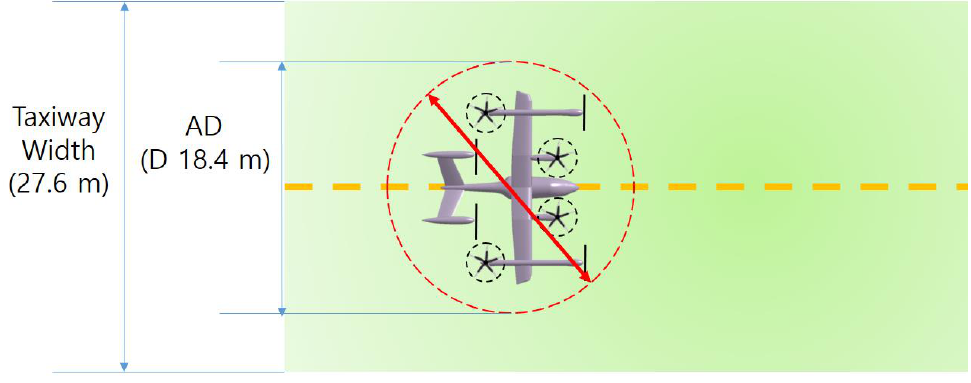
Figure 6. Taxiway width for S-A1.